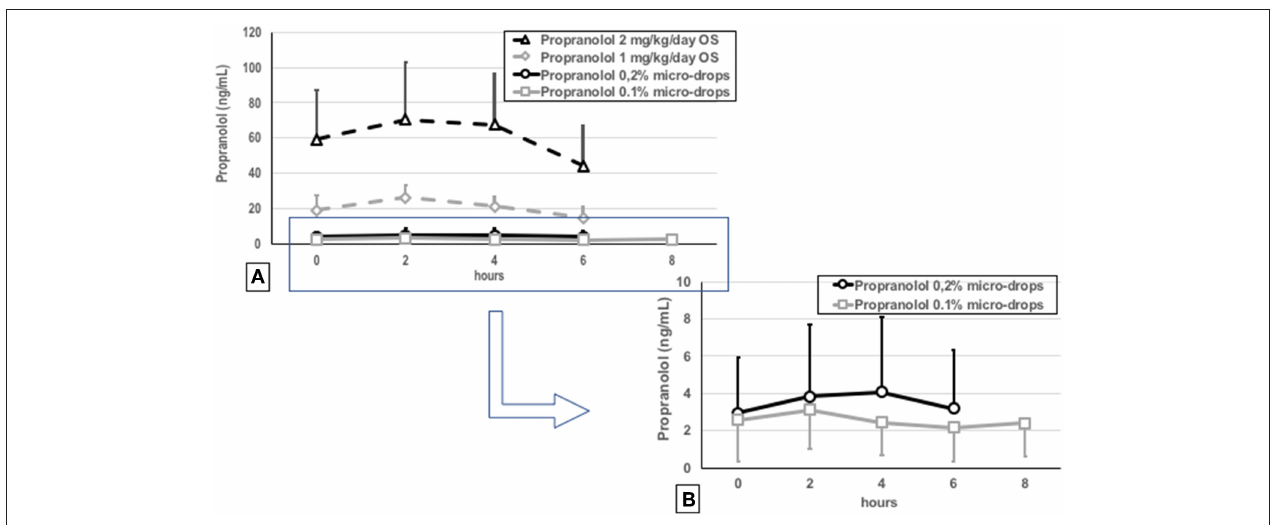
FIGURE 3 | Plasma propranolol concentrations measured by dried blood spots in the newborns treated with 0.2% eye micro-drops ( continuous black line ), in the tenth day of treatment, compared with plasma concentrations obtained in the previous studies after 0.1% eye micro-drops ( continuous gray line) (15), oral 1 mg/kg/day ( dotted gray line ) or oral 2 mg/kg/day ( dotted gray line ) propranolol administration (A) (9). Magnification of results observed with 0.2 and 0.1% eye micro-drops (B) .